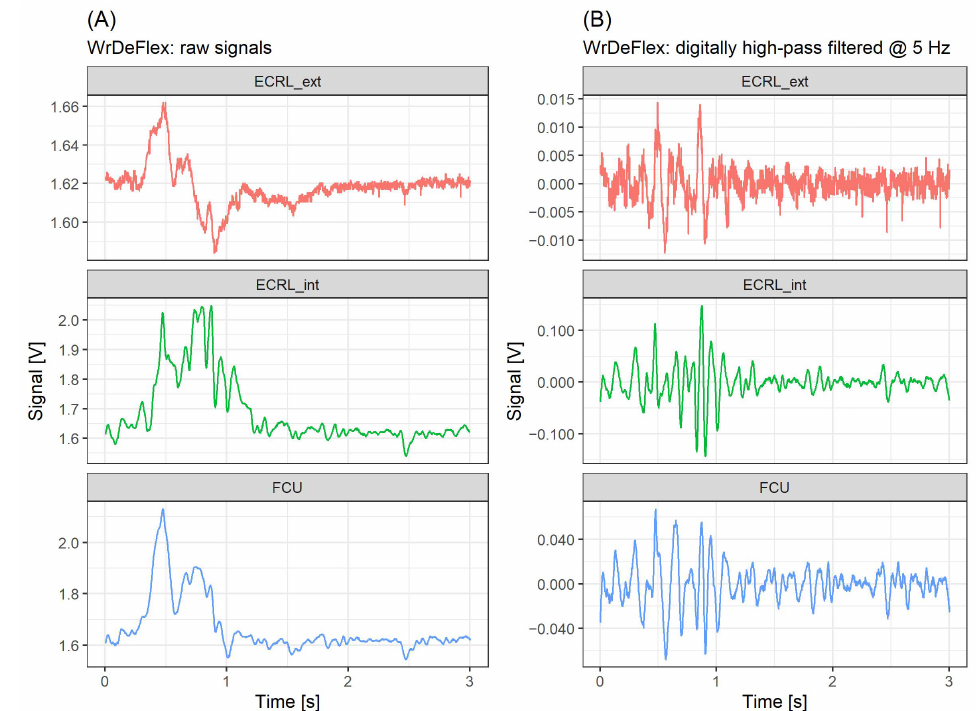
Figure 11. Example of signals acquired during the wrist de-flexion (WrDeFlex): ( A ) raw and ( B ) digi- tally high-pass filtered at 5 Hz. The signal sites abbreviations: ECRL_ext\ECRL_int–extensor carpi radialis longus, external\internal piezoelectric disc of the sensor, respectively; FCU—flexor carpi ulnaris, internal piezoelectric disc of the